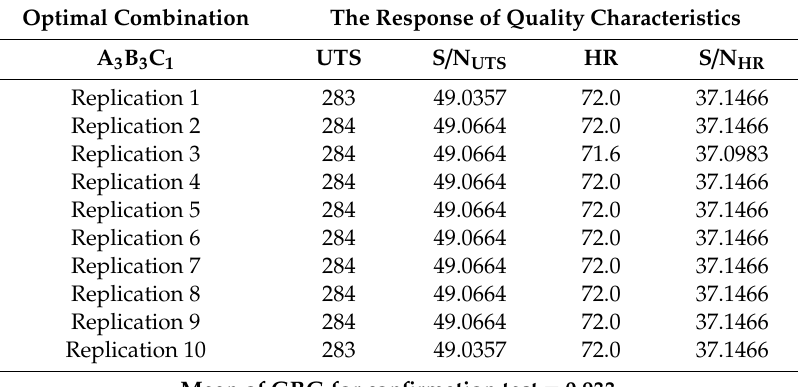
Table 20. Results of the confirmation